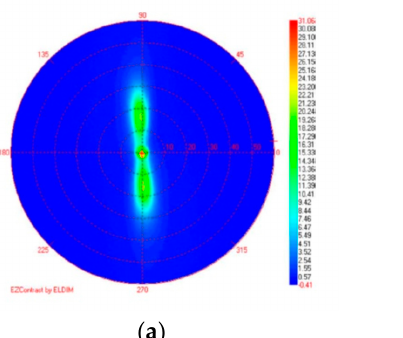
crossed polarizers, and right insertion shows the intensity profile of the diffraction lobe [44].